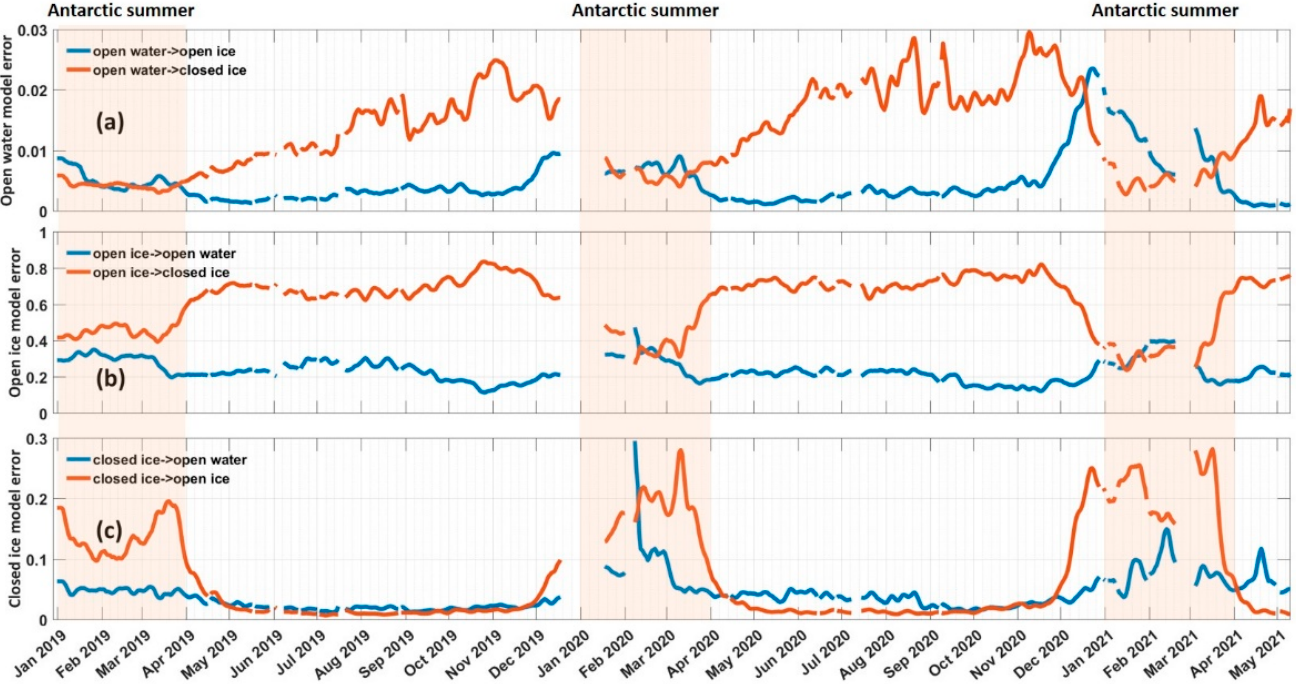
Figure 11. The error analysis of the Antarctic sea ice monitoring training models from 1 January 2019 through 10 May 2021: ( a ) open water is misclassified as open ice (blue line) and closed ice (red line), respectively, ( b ) open ice is misclassified as open water (blue line) and closed ice (red line), respectively, and ( c ) closed ice is misclassified as open water (blue line) and open ice (red line), respectively.